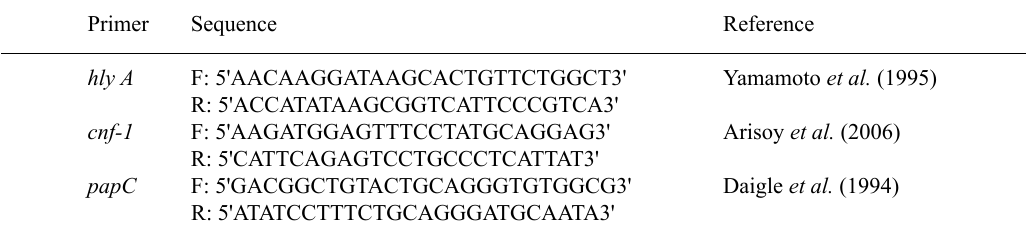
table 1. Primers’ Sequences